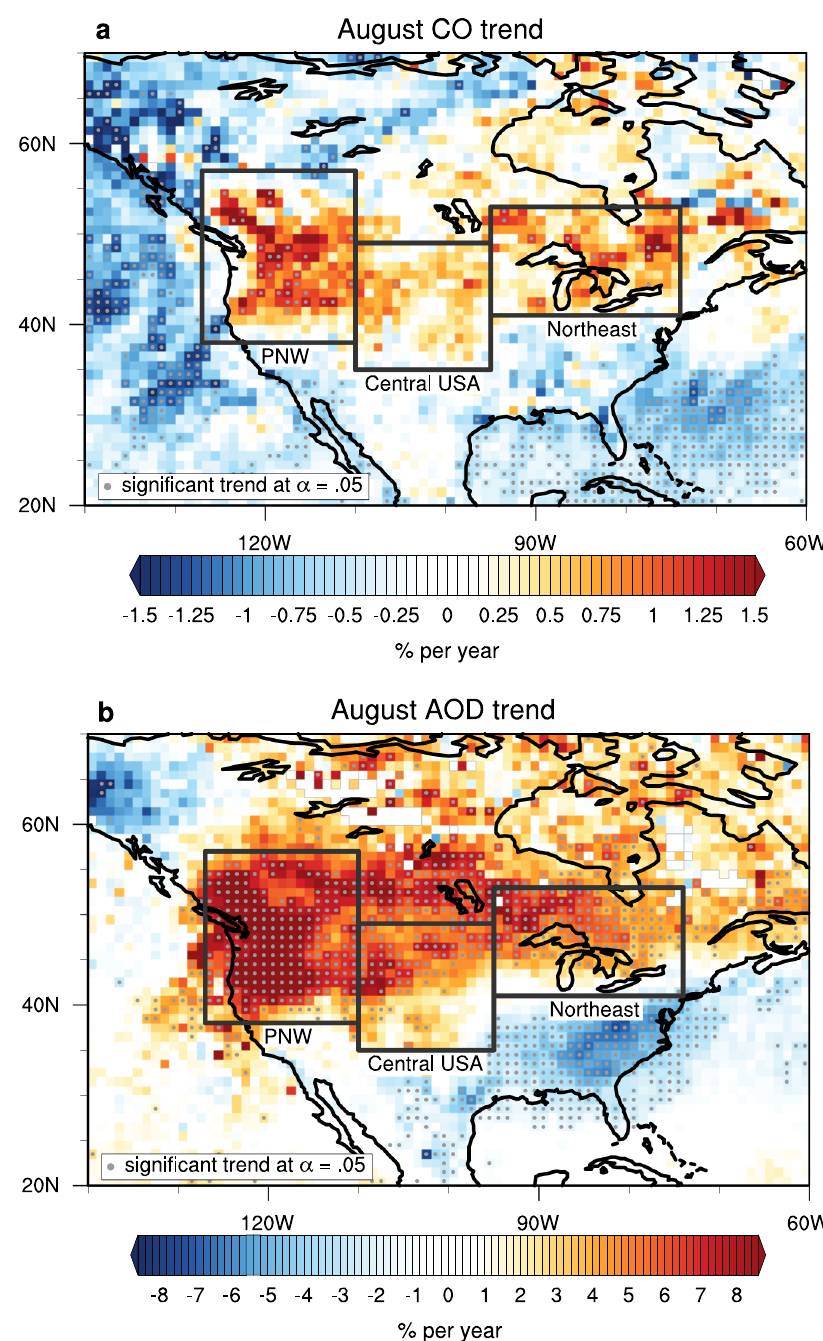
Fig. 1 August trend analysis of atmospheric composition. August trend (2002 – 2018) in satellite-measured atmospheric composition is shown in a 1×1 degree grid. a Column carbon monoxide (CO) trends ( n = 16) and b aerosol optical depth (AOD) trends ( n = 17). Gray dots indicate signi fi cant non-zero trends, α = 0.05. De fi ned regions are outlined in black: Paci fi c Northwest (PNW, 38 ∘ – 57 ∘ N, 127 ∘ – 110 ∘ W), Central USA (35 ∘ – 49 ∘ N, 110 ∘ – 95 ∘ W), and the Northeast (41 ∘ – 53 ∘ N, 95 ∘ – 74 ∘ W). White areas outlined in gray denote missing